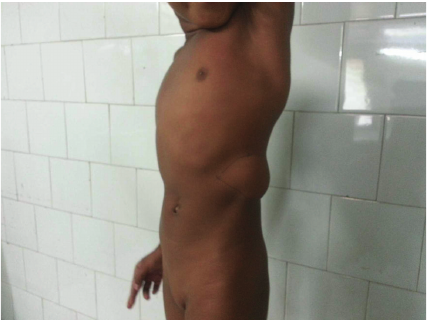
Figure 4: The defect in the hypoplastic musculature.